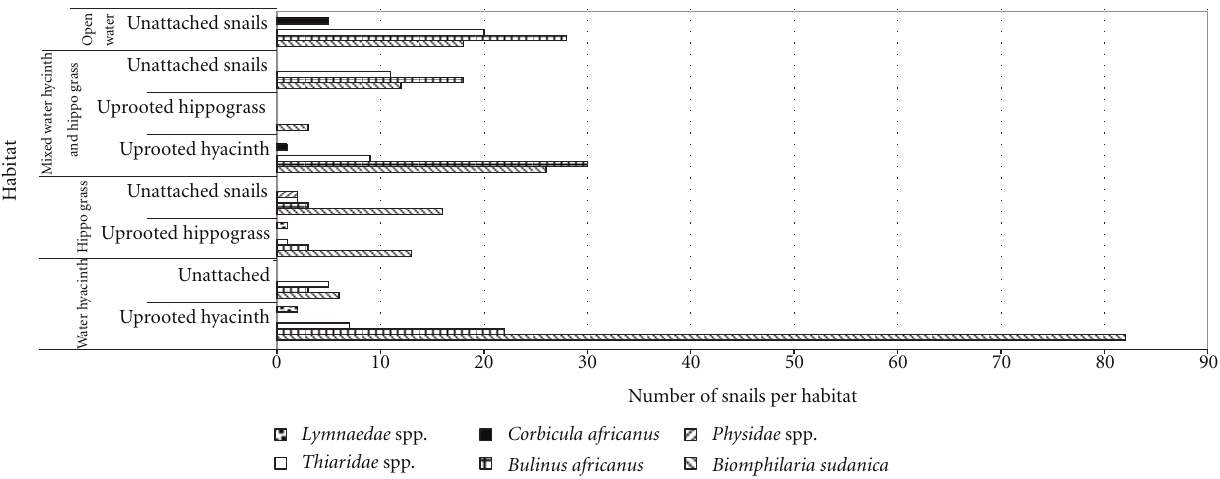
Figure 8: Relative abundance of di ff erent invertebrate species collected in the habitats of water hyacinth and hippo grass and in open water at di ff erent sites within the Nyanza Gulf of Lake Victoria.